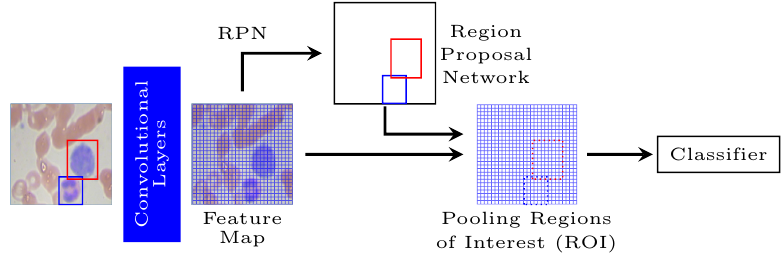
Figure 2. Representation of Faster R-CNN